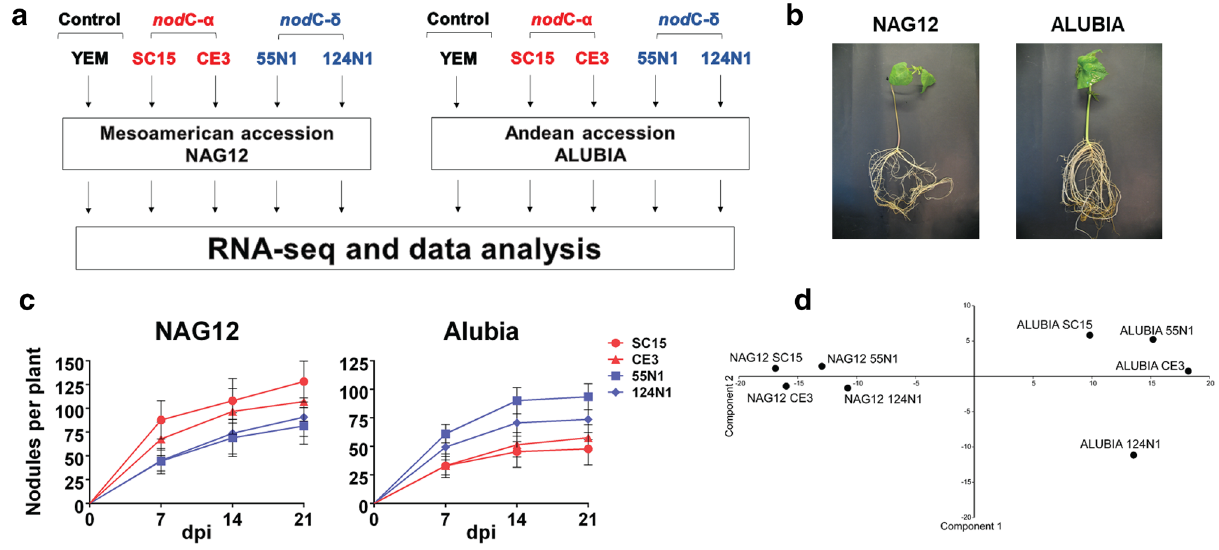
Figure 1. Experimental design to explore strain-specific transcriptomic changes in the P. vulgaris – R. etli symbiotic interaction. ( a ) Diagram of the experimental design used for RNA-seq studies. P. vulgaris NAG12 and Alubia were chosen as representative accessions of the Mesoamerican and Andean genetic pools, respectively. Groups of at least five plants from each accession were treated with growth-culture media (YEM, yeast extract mannitol) as control or inoculated with one of the following R. etli strains: SC15 and CE3, carrying a nod C-α allele or 55N1 and 124N1 carrying a nod C-δ allele. Three biological replicates were obtained for each accession and condition. ( b ) Representative pictures of NAG12 and Alubia accession plants exhibiting comparable root development at 14 days post-inoculation with rhizobia. ( c ) Nodulation kinetics of NAG12 and Alubia accessions inoculated with SC15, CE3, 55N1 or 124N1. The mean number of nodules per plant at 7, 14 and 21 days post inoculation (dpi) is shown (n ≥ 7). Error bars represent the standard error of the mean (SEM). ( d ) Principal component analysis (PCA) plot of NAG12 and Alubia root transcriptomes in response to SC15, CE3, 55N1 or 124N1. Gene expression values used for the analysis were normalized by the corresponding YEM value. The first and second principal components explain 83.0% and 9.7% of the variance,